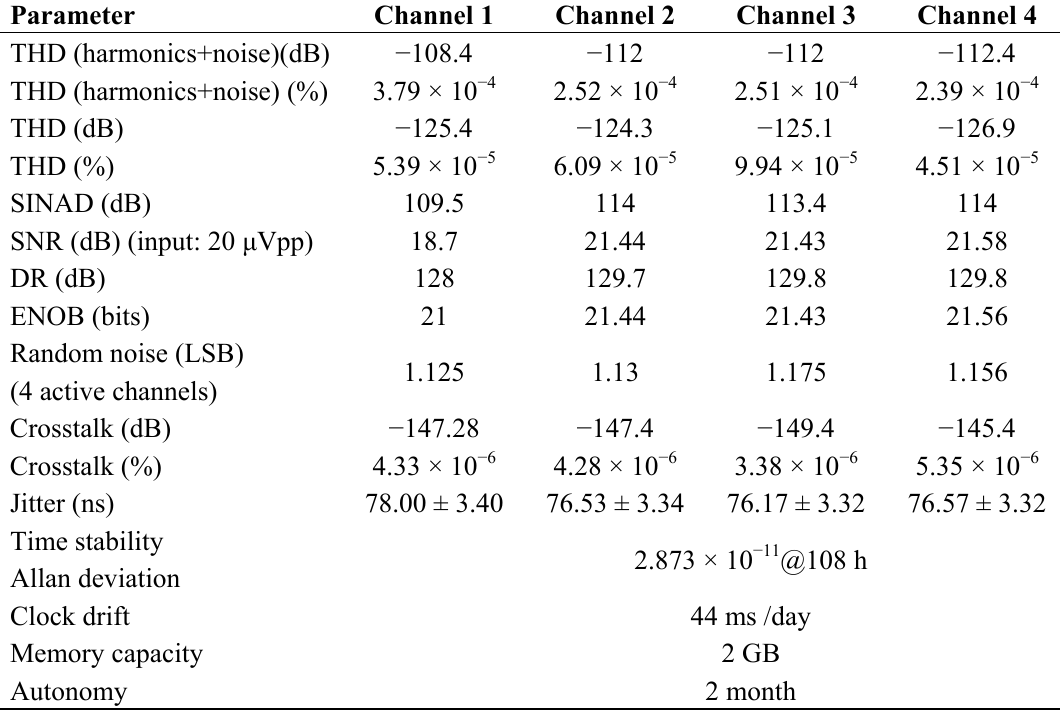
Table 6. Data registry system and storage system characteristics.